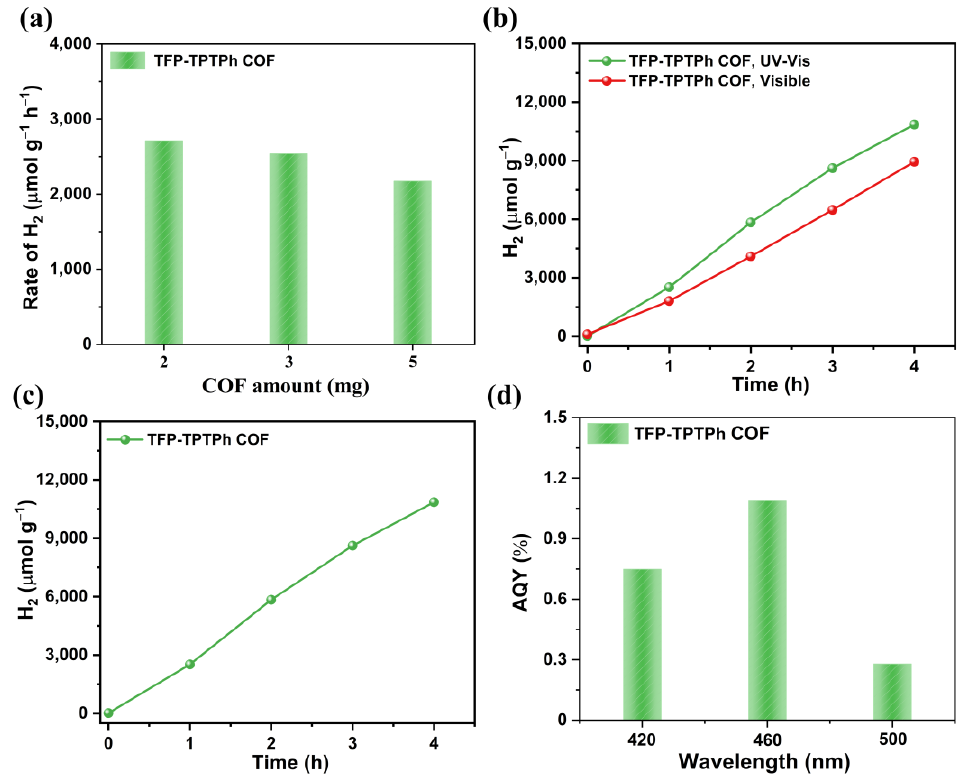
Figure 6. ( a ) Effect of TFP-TPTPh COF photocatalyst amount on the hydrogen production activity. ( b ) Effect of illumination source on the hydrogen production activity. ( c ) Hydrogen production activity over four hours of using TFP-TPTPh COF photocatalyst under ultraviolet and visible light irradiation. ( d ) AQYs of the TFP-TPTPh COF photocatalyst that measured at different wavelengths of light.